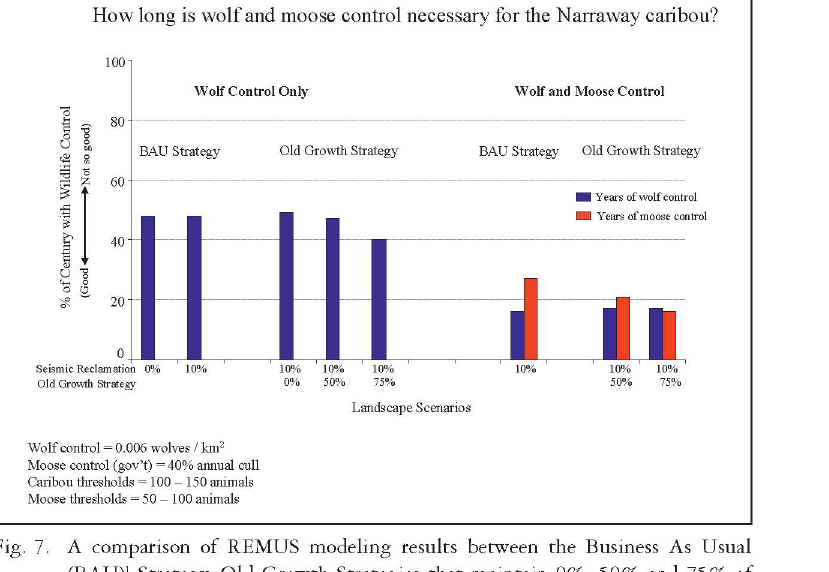
Fig. 7. A comparison of REMUS modeling results between the Business As Usual (BAU) 1 Strategy, Old Growth Strategies that maintain 0%, 50% and 75% of the forest > 80 years old and wolf control only vs. moose and wolf control in the Narraway Range. The blue bars illustrate the number of years out of 100 when wolf control would be necessary and the red bars illustrate how many years out of 100 that government moose control (i.e. probably couldn't be accomplished by sport hunting) would be required to maintain 100 - 150 caribou.